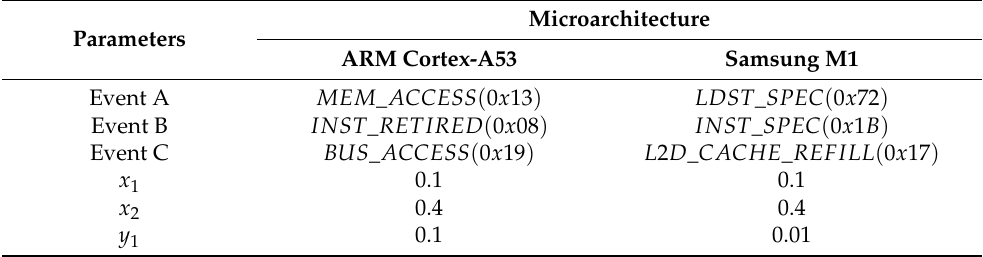
Table 3. Parameters for CPU phase